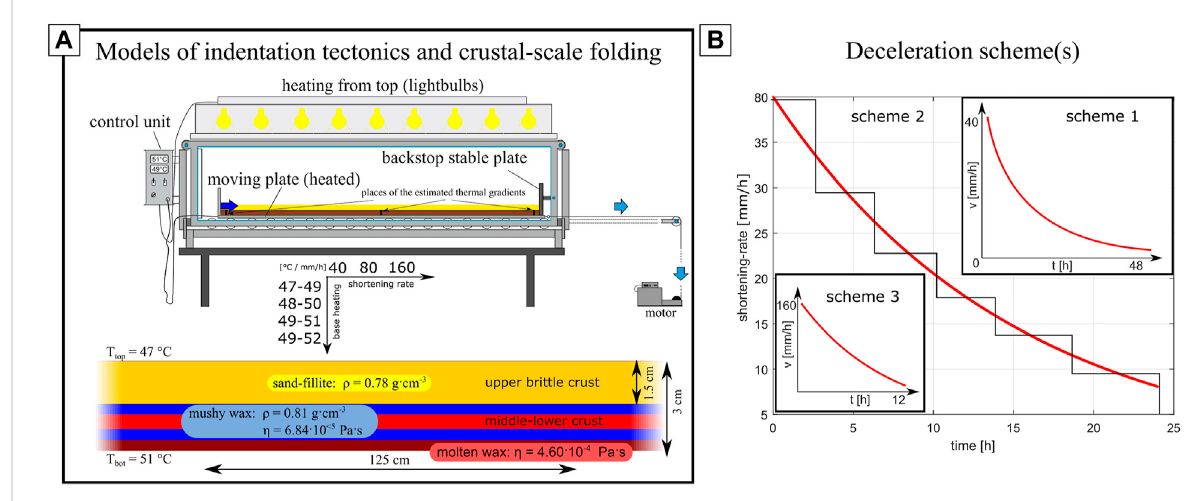
FIGURE 2 The model setup. Experimental apparatus and model properties (A) including dimensions, materials (values correspond to the base heating at 51 ° C)and strategy ofmodeling coveredbyvariablethermaland initial shortening rates ( T,V ).The prefabricated wax prisms (lower crustinthemodel) were composed of several contrasting layers. Mechanically inert glitter and fl uorescent wax particles were superposed at the frontal side of the prisms. The thermal gradients are marked by ~ 0.07 ° C – 0.1 ° C/mm at the sides and the center of the model domain, respectively. In the further text, we use a simpli fi ed notation as the ratio of averaged temperatures ( T ) to the melting point of the wax (T m ). Individual shortening schemes (B) as calculated for decelerated systems (see text and Supplementary material for more information). Implementation of deceleration was performed by splitting of curves to segments with constant piston velocities due to limitations of the stepping motor. For further information, follow the main text and see Table